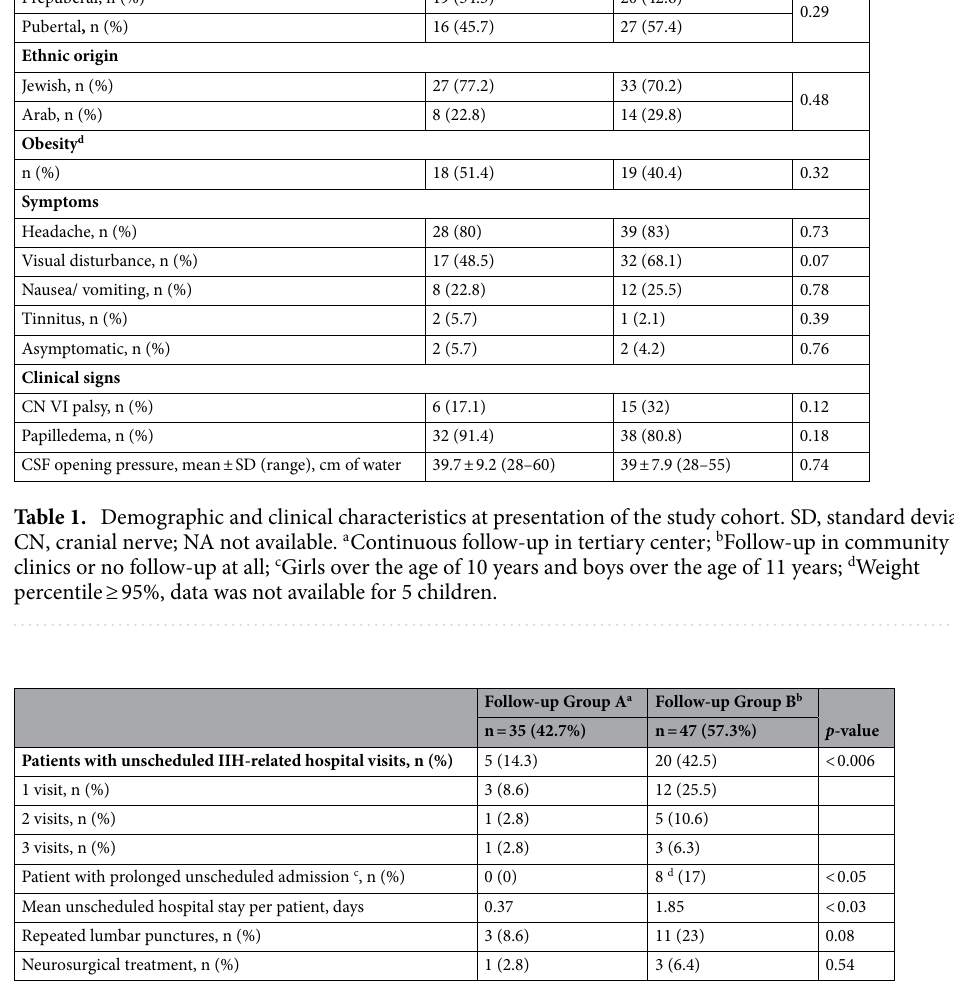
Table 2. Primary outcome of the follow-up groups. SD, standard deviation; a Continuous follow-up in tertiary center; b Follow-up in community clinics or no follow-up at all; c hospital stay longer than 96 h; d One patient had two prolonged admissions.